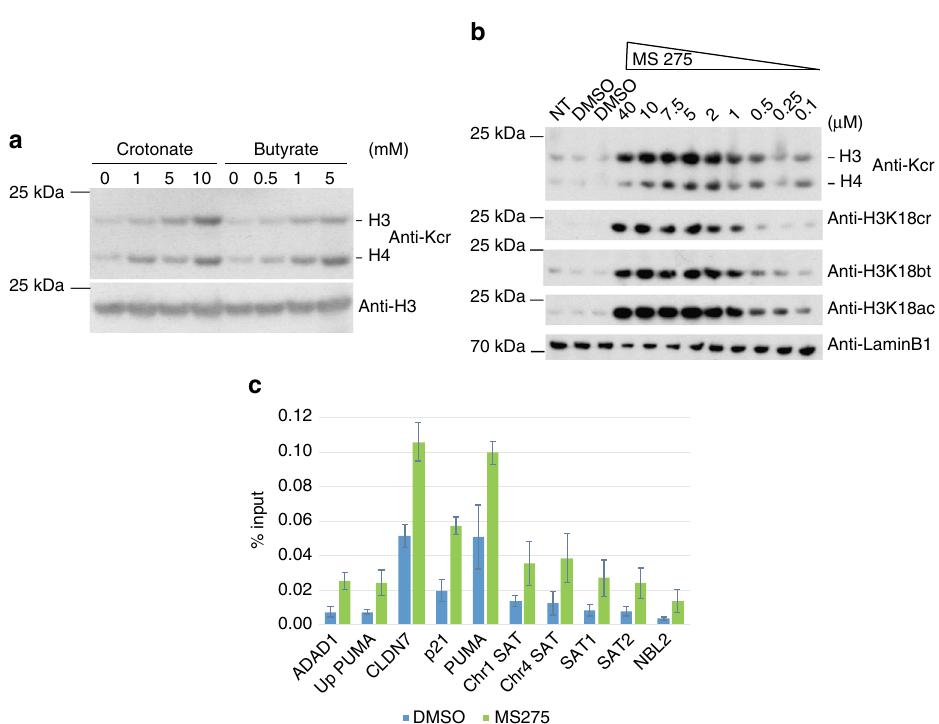
Fig. 4 Butyrate and class I HDAC inhibition promote histone crotonylation. a Western blot analysis with indicated antibodies of whole cell extracts of small intestinal organoids treated for 48 h with indicated amounts of SCFAs. Representative western blot of two repeat experiments. b HCT116 cells were treated with MS275 or DMSO (vehicle) for 18 h, whole cell extracts collected, and analyzed by western blot using indicated antibodies; anti-Kcr: anti-crotonyl- lysine antibody, NT: not treated. c Increase in histone H3K18cr over promoters of indicated genes and repetitive, heterochromatic sites (alpha-satellite sequences, NBL2) upon MS275 treatment of HCT116 cells for 18 h. Summary of ChIP-qPCR data of three repeat experiments, error bars are